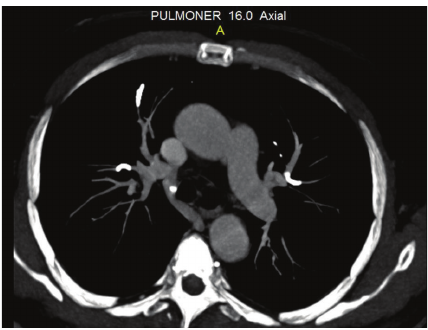
Figure 1: PA radiography showed linear densities in the left lower zone and elevation of the left diaphragm.